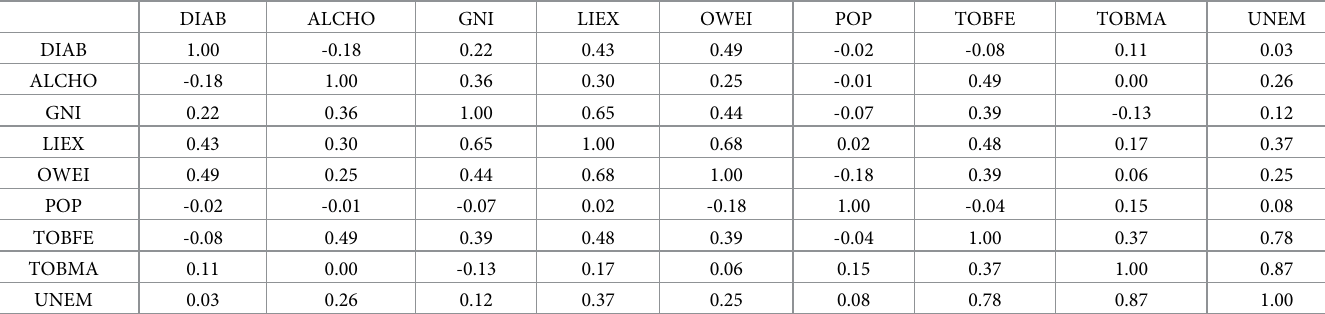
Table 3. Cross correlation matrix of socioeconomic and lifestyle variables, for 132 countries and territories.